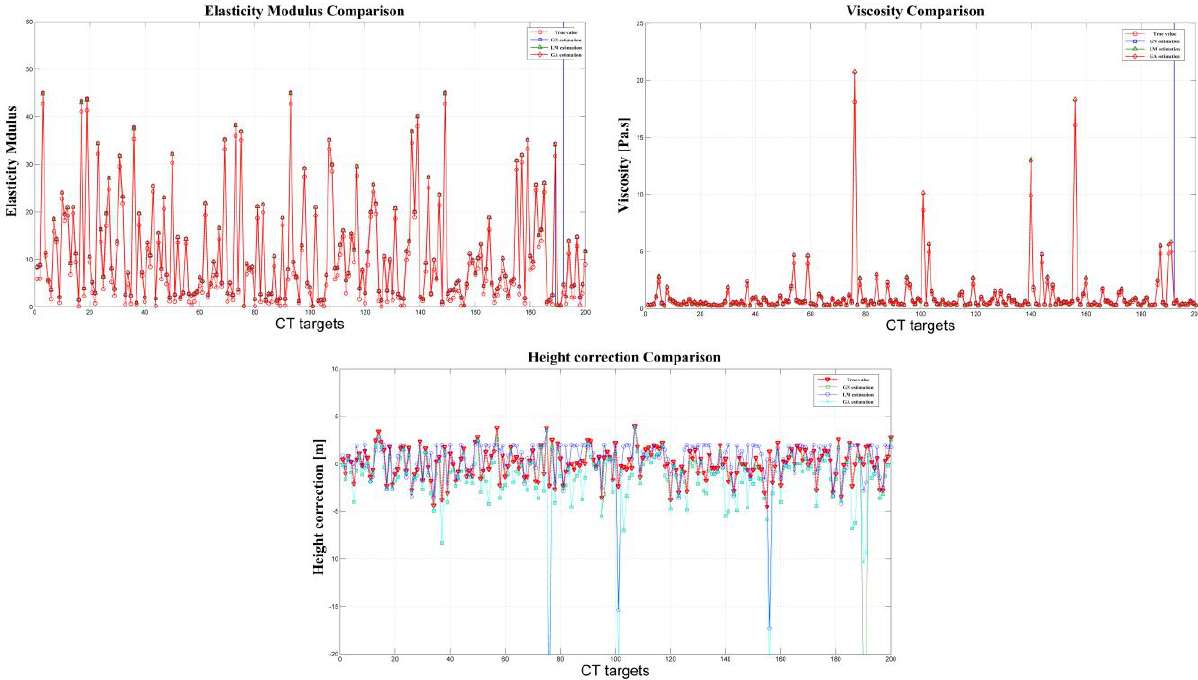
Figure 2. Simulated parameters comparison